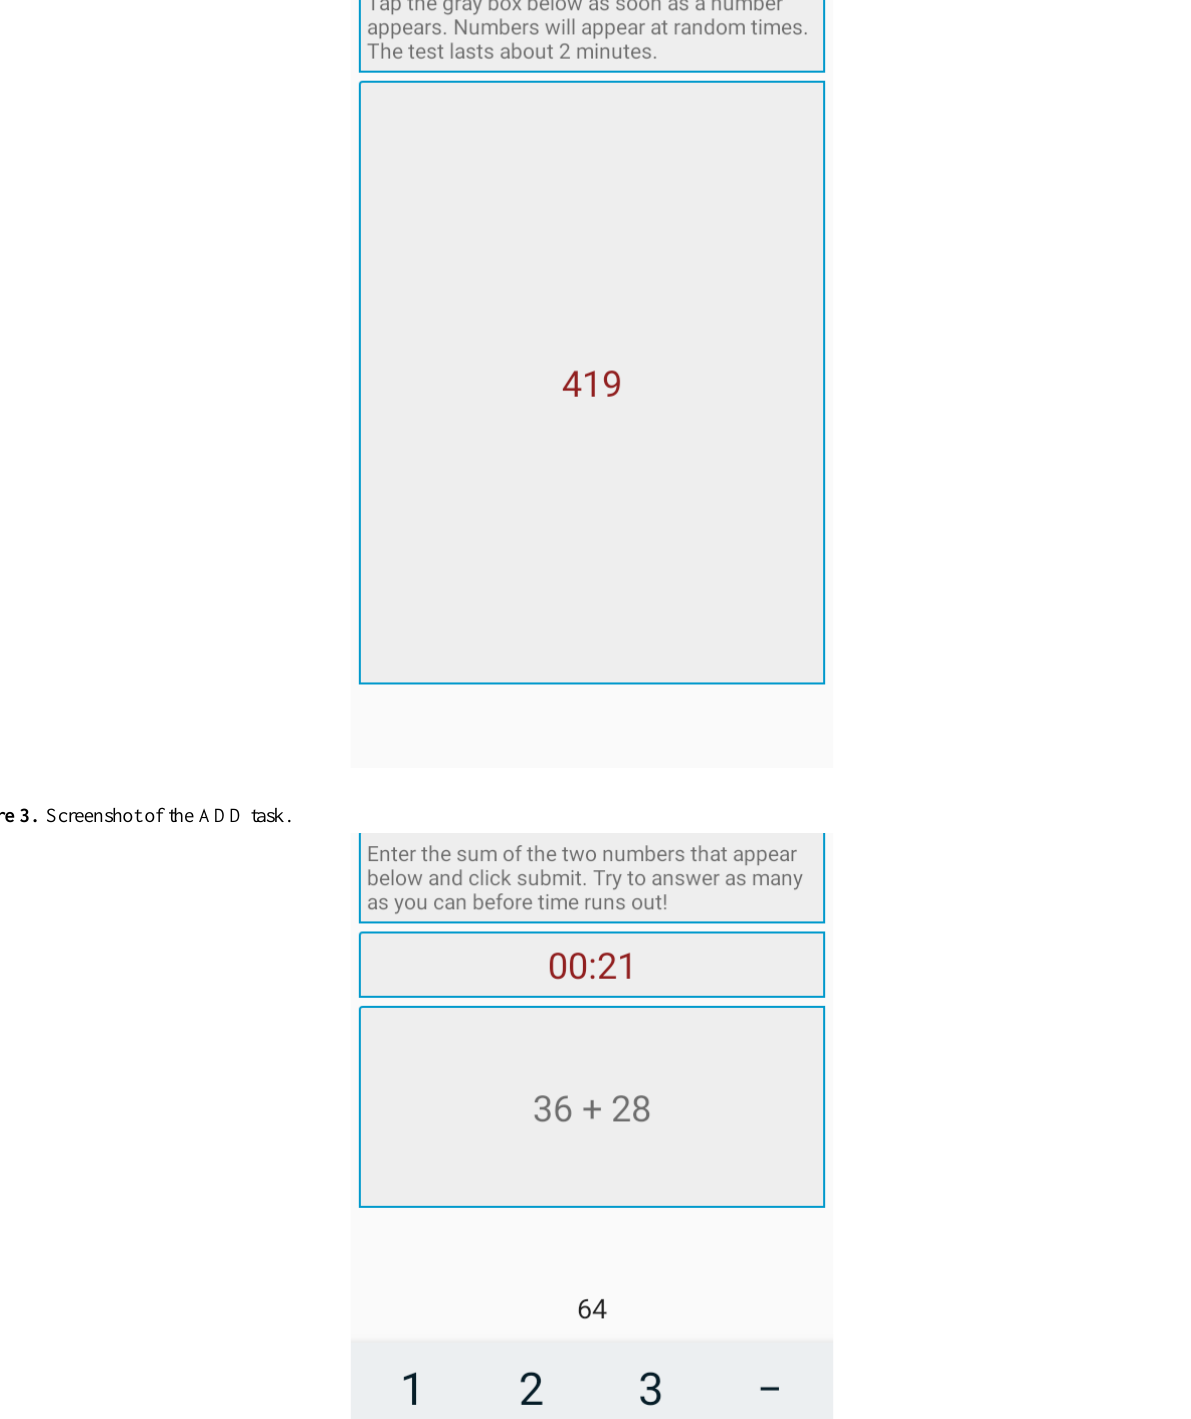
Figure 2. Screenshot of the PVT task.